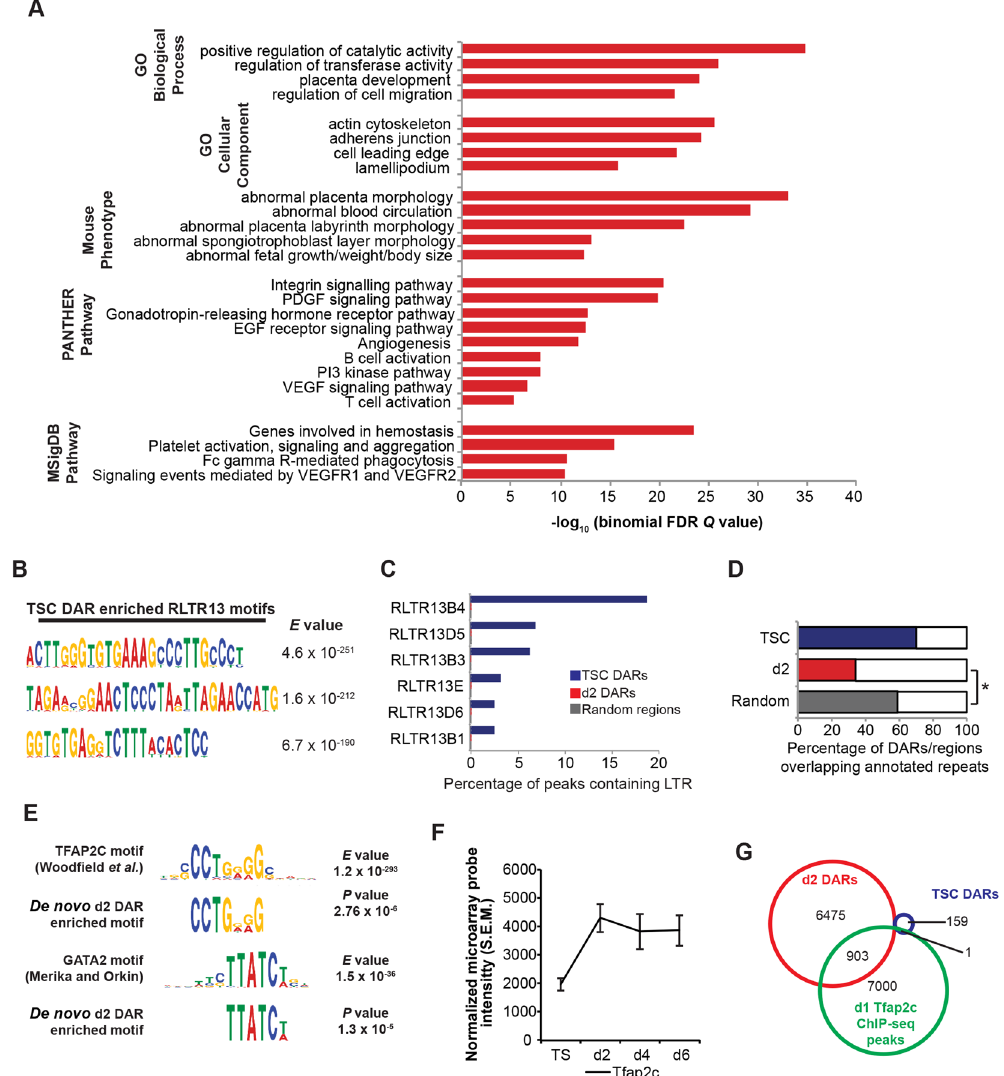
Figure 3. Regulation of trophoblast function and placenta development by genomic loci showing changes in chromatin accessibility during TSC differentiation. ( A ) Functional annotation analysis of genes with d2 DARs (nearest TSS ± 100 kb) using GREAT 84 . ( B ) Sequence motifs identified in TSC DARs using MEME-ChIP and associated E value confidence scores. ( C ) Comparison of RLTR13 family repeats located within TSC and d2 DARs, and random genomic regions. ( D ) The percentages of TSC and d2 DARs, and random genomic regions overlapping annotated repeats. Significant under-representation of repeat regions in d2 DARs was determined using Chi-square test. * P = 7.3 × 10 − 217 . ( E ) Sequence motifs identified in d2 DARs using MEME-ChIP aligned with published Tfap2c and GATA2 consensus binding motifs 89, 90 . Both E value confidence scores for de novo motif identification and P value for match to published motif are shown. ( F ) Microarray expression profile of Tfap2c during wild type trophoblast differentiation. ( G ) Overlap of TSC and d2 DARs with published Tfap2c ChIP-seq peaks 31 . See also Supplementary Figure